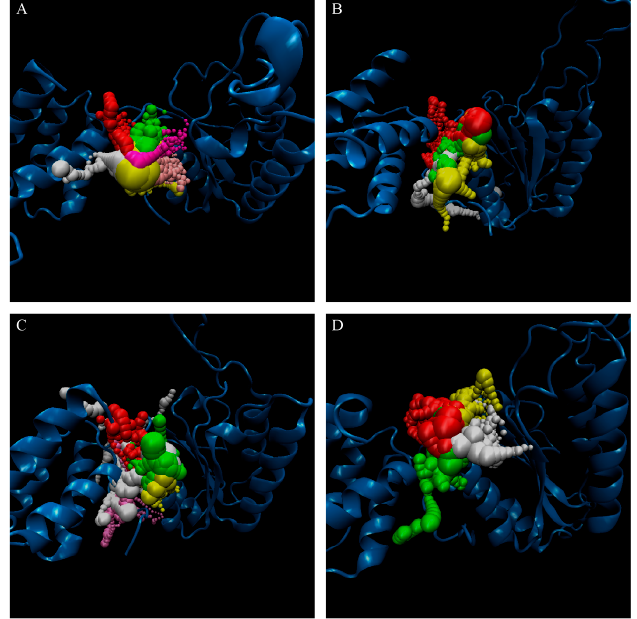
Figure 14. Analysis of transport pathways for paraplegin protein in ( A ) apo form and complexes with ( B ) 5-hydroxy- L -tryptophan; ( C ) saussureamine C; and ( D ) 3-(2-carboxyphenyl)-4(3 H )-quinazolinone.